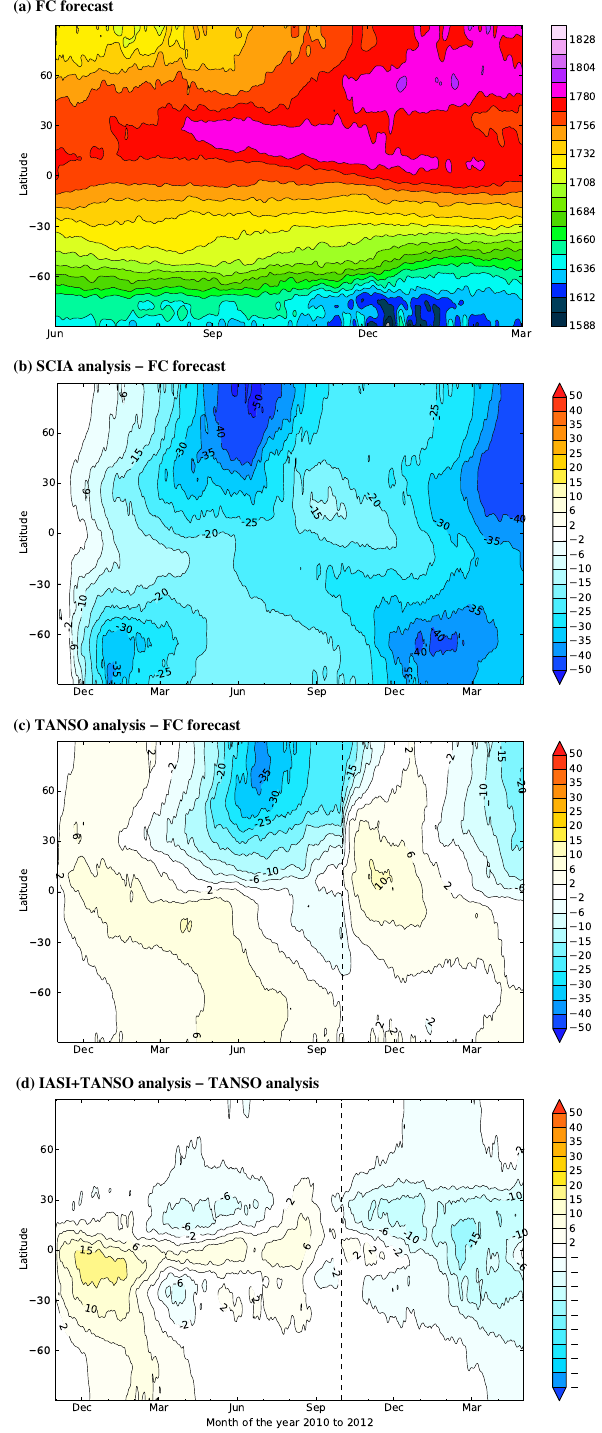
Figure 5. Time series of xCH 4 zonal mean (in ppb). From top to bottom: (a) FREE free run, (b) SCIA analysis – FREE, (c) TANSO analysis – FREE, (d) IASI+TANSO analysis – FREE. The vertical dotted line corresponds to the date when version v.2.0 of the data replaces version